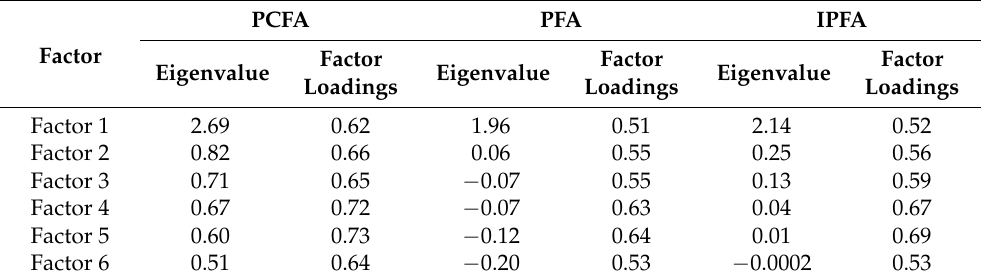
Table 1. Exploratory Factor Analysis Results ( n =